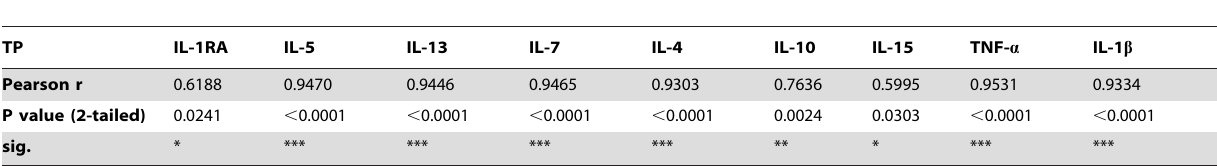
Table 4. Cytokines showing significant correlations with IFN- c in tuberculous pleurisy plasma.